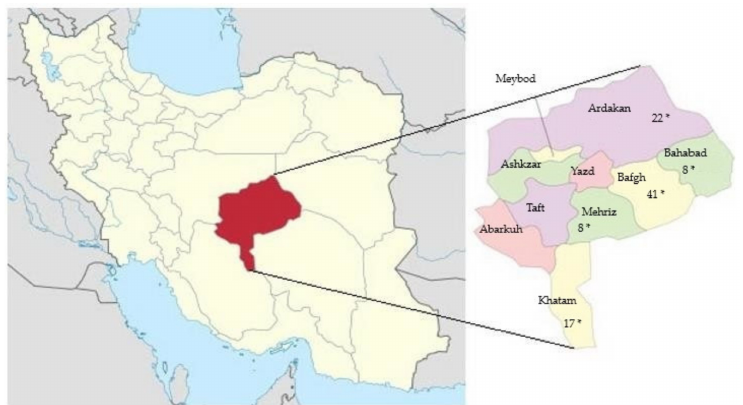
Figure 1. Yazd province, the central desert of Iran. *: samples collected